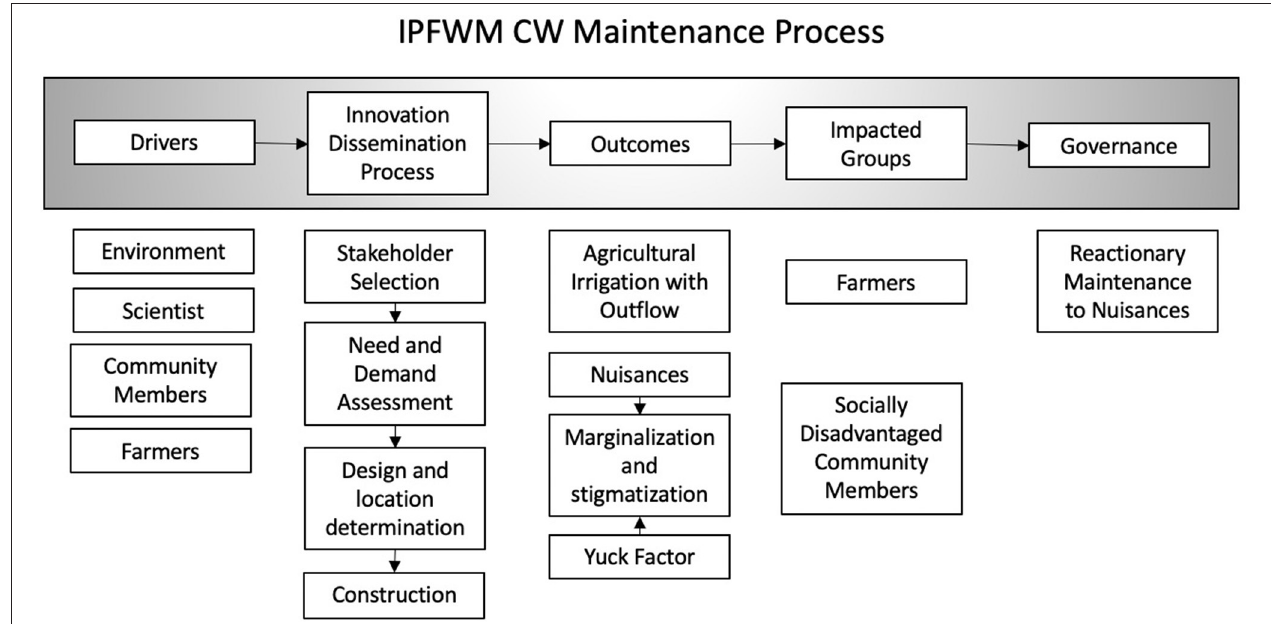
FIGURE 2 | IPFWM CW implementation and maintenance